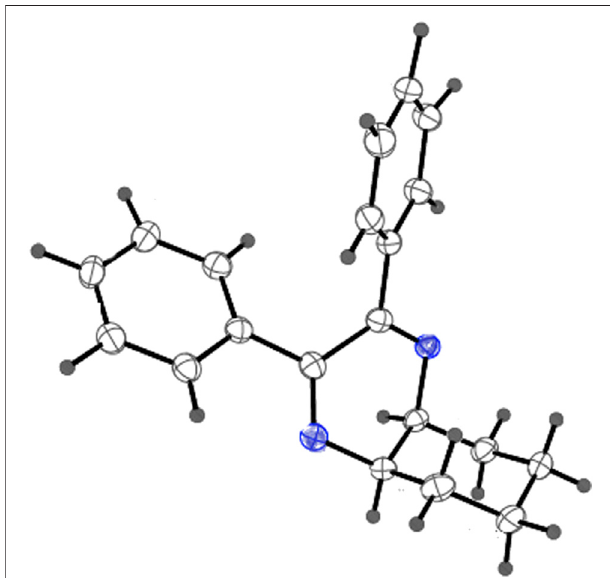
FIGURE 6 | X-ray crystallographic structure (ORTEP) of Compound 2 . Thermal ellipsoids are shown with 50% probability.